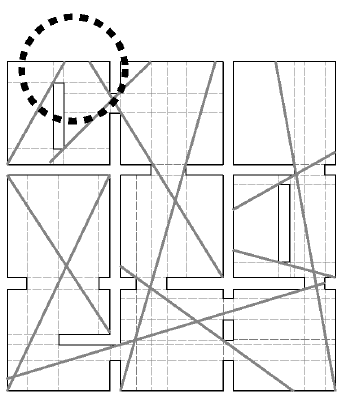
Figure 2. A minimal set of axial lines that “get everywhere” ( n = 11).